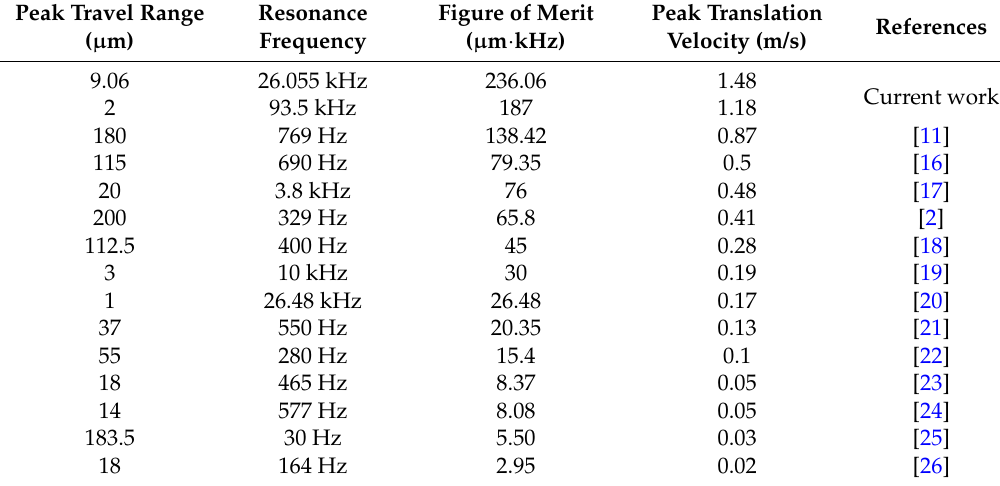
Table 1. Brief survey of the in-plane electrostatic actuators operated under atmospheric